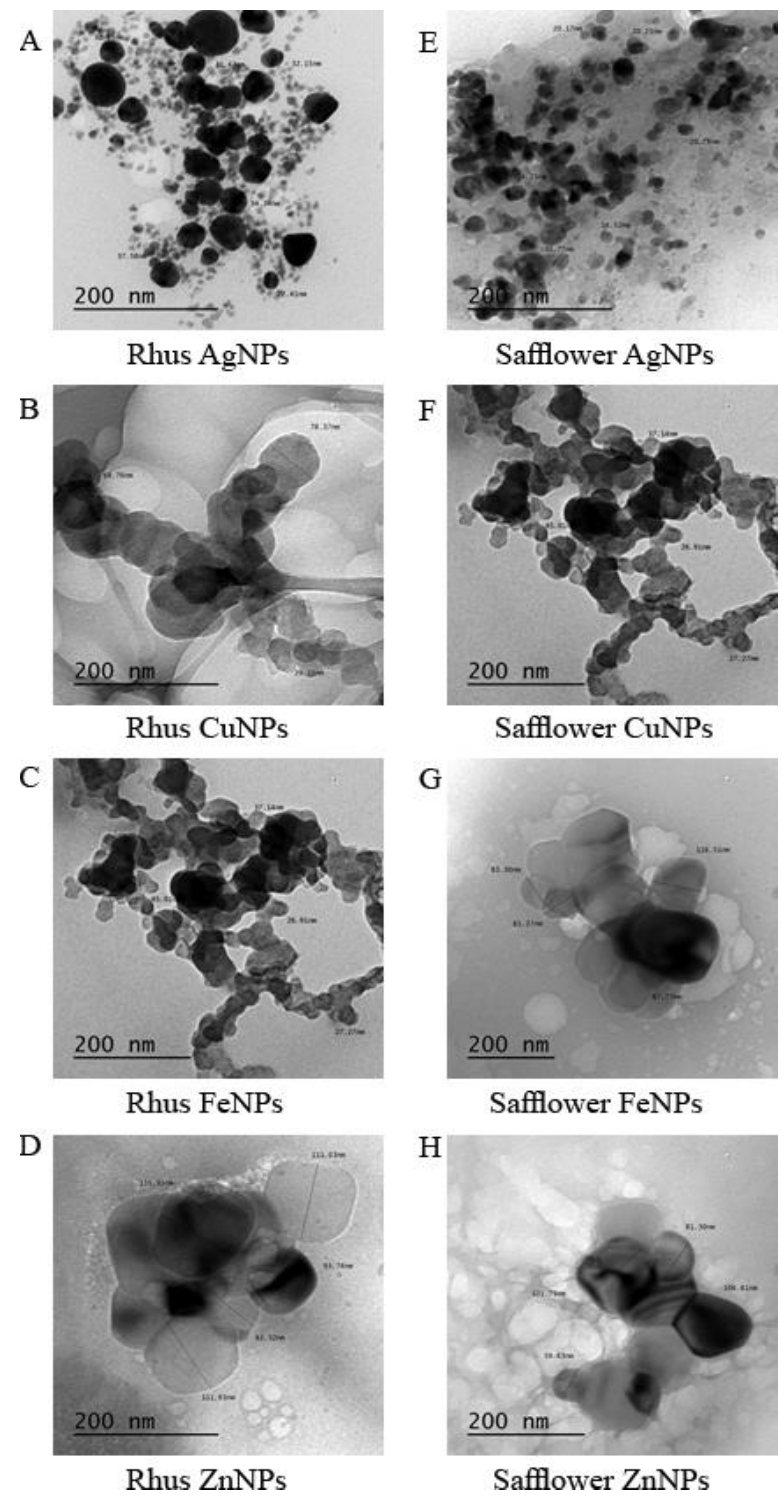
Figure 3. TEM micrographs characterization illustrating the size and morphology. AgNPs ( A ), CuNPs ( B ), FeNPs ( C ), and ZnNPs ( D ) obtained with rhus extracts and AgNPs ( E ), CuNPs ( F ), FeNPs ( G ), and ZnNPs ( H ) obtained with safflower extracts. Scale bar = 200 nm.